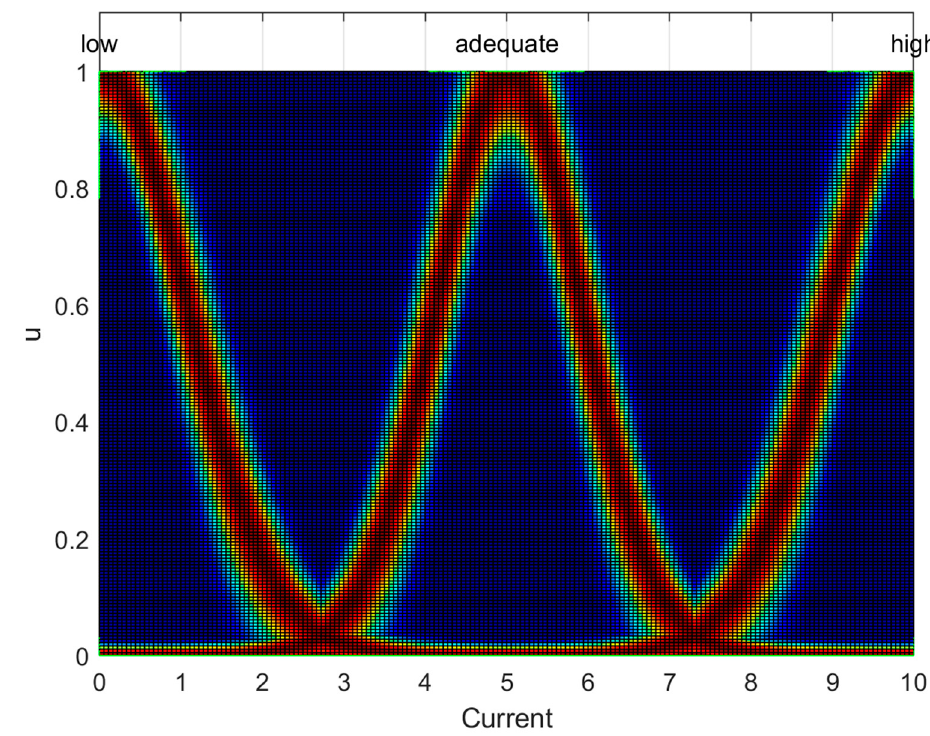
Figure 9. Input MFs of the electric current intensity variable.